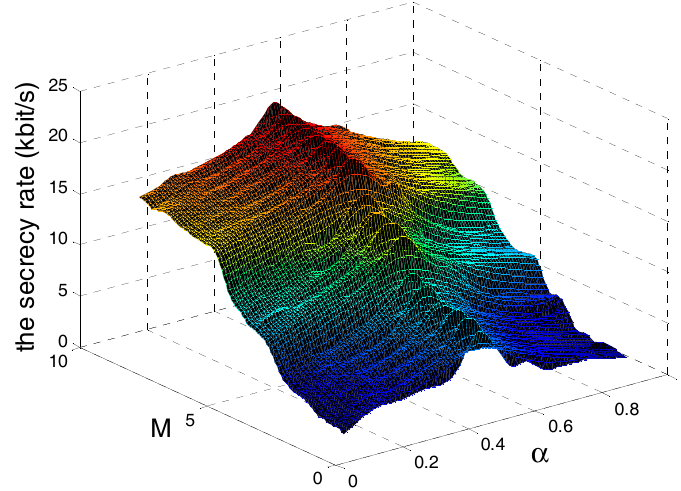
= σ 2 = 0.01 and 1, i 2, i